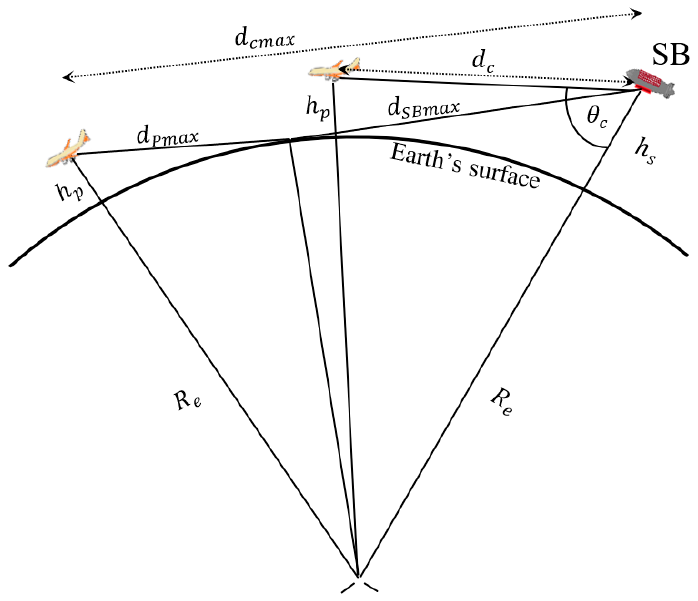
Figure 2. A simple aircraft–stratospheric basestation (SB) communication link geometrical model.